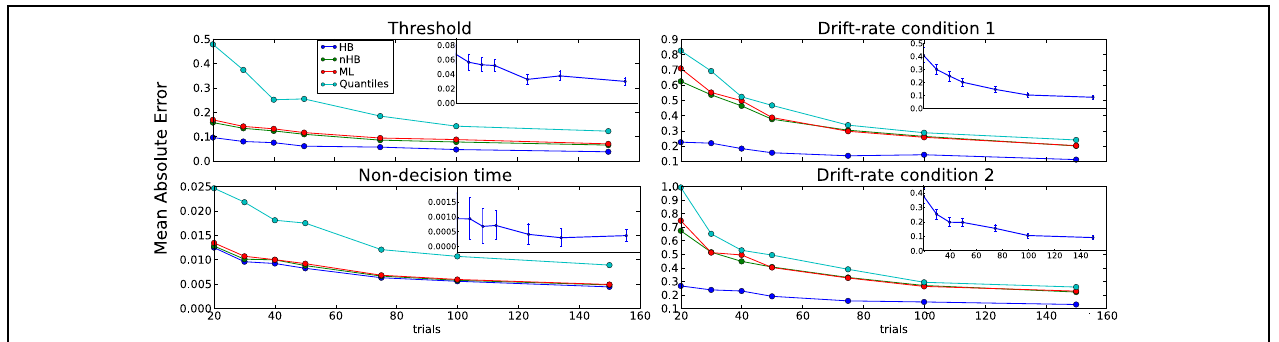
FIGURE 6 | Trials experiment. Trimmed mean absolute error (MAE, after removing the 2.5 and 9.75 percentiles) as a function of trial number for each DDM parameter. Colors code for the different estimation methods (HB, Hierarchical Bayes; nHB, non-hierarchical Bayes; ML, maximum likelihood; and Quantiles, χ 2 -Quantile method). The inlay in the upper right